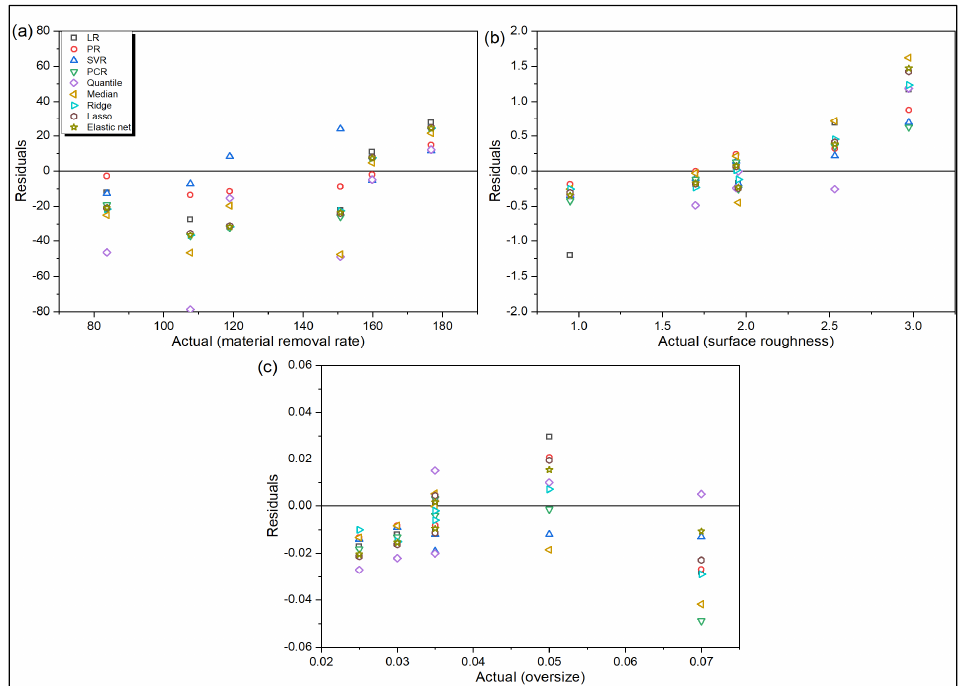
Figure 5. Actual responses versus residuals for drilling ( a ) MRR ( b ) Ra ( c ) OS.